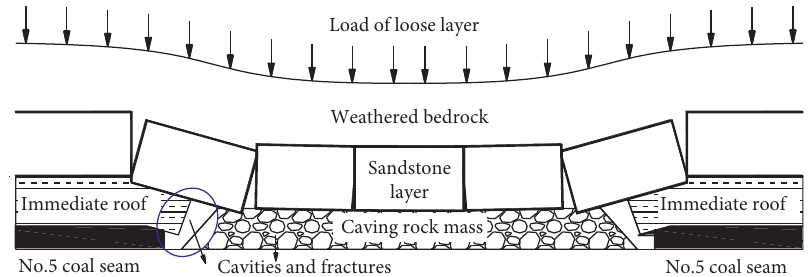
Figure 4: Bedrock structure of the weathered bedrock, sandstone layer, and collapsed